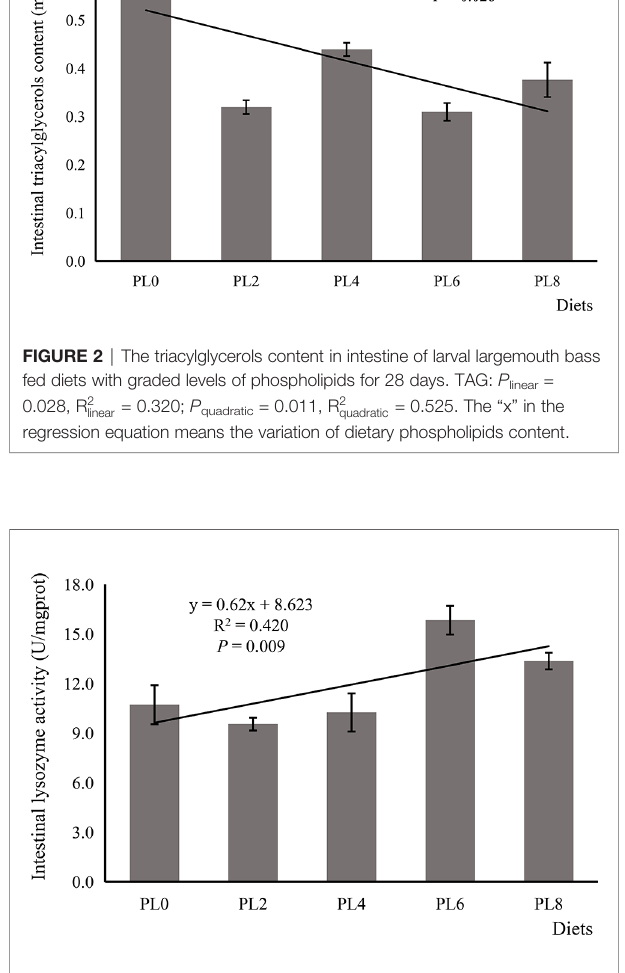
FIGURE 3 | The lysozyme activity in intestine of larval largemouth bass fed diets with graded levels of phospholipids for 28 days. P linear = 0.009, R 2 linear = 0.420; P quadratic = 0.037, R 2 quadratic = 0.423. The “ x ” in the regression equation means the variation of dietary phospholipids content.